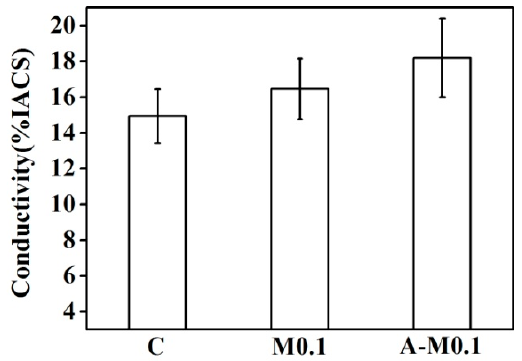
Figure 7. Conductivity of alloys solidified with the Ag multi-alloying and combined process.